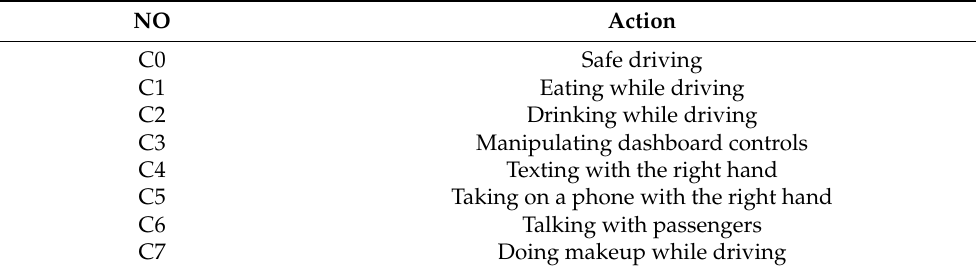
Figure 1. Some sample frames of distracted actions from the custom dataset. Table 2. Actions of the